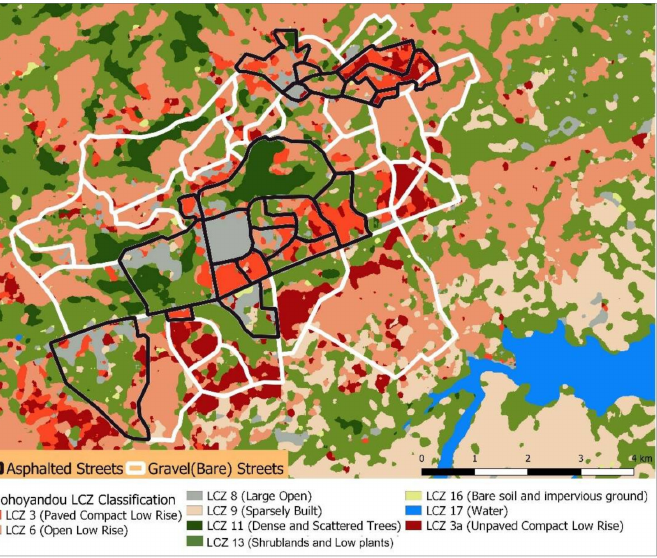
Figure 13. Thohoyandou classification output for multitemporal with neighborhood function with local customized training showing asphalted and gravel